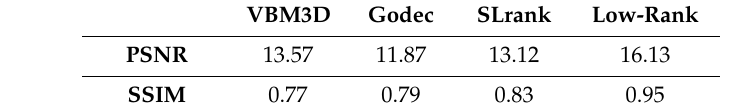
Table 1. Average peak signal-to-noise ratio (PSNR) and structure similarity (SSIM)for di ff erent restoration methods.